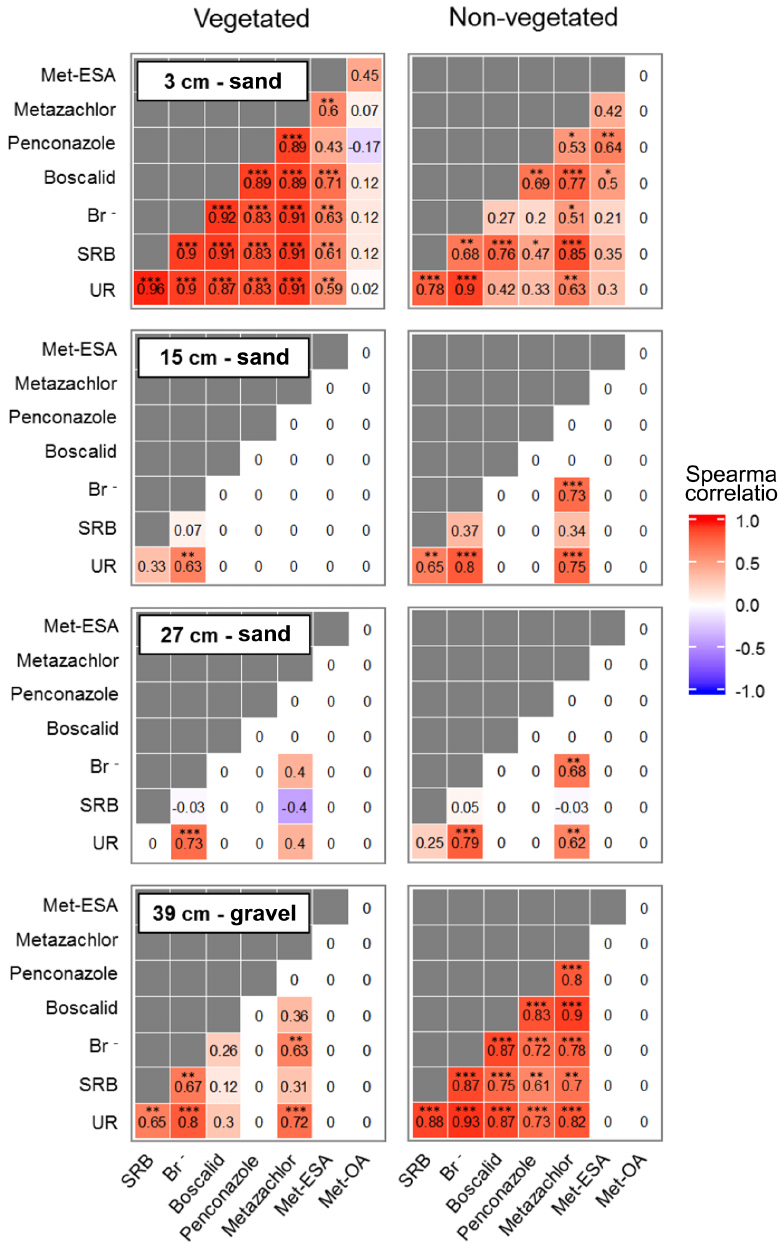
Figure 7. Spearman correlation matrices between the relative concentration of tracers, pesticides and their TPs in the pore water during the whole experiment, distinguishing between the different depths and zones. The significance levels are displayed as follows: p < 0.001 ∗∗∗ ; p < 0.01 ∗∗ ; p < 0.05 ∗